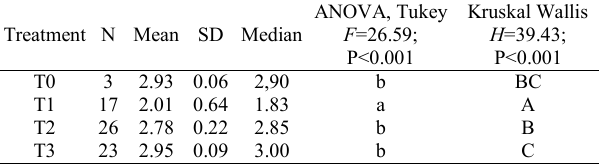
Fig. 6. Mean histological condition index (HCI) and standard error for Pagrus pagrus larvae from the feeding treatments calculated employing short or long term tissues and a mean value employing all tissues. Different letters indicate significant differences (p<0.05) among feeding treatments, after one way ANOVA followed by post-hoc Tukey’s